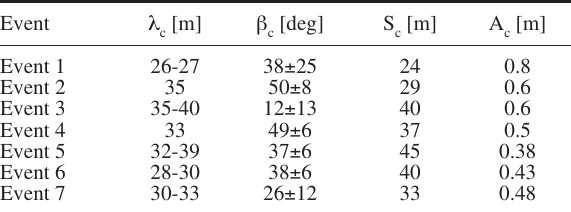
, orientation β , protruding distance S c c